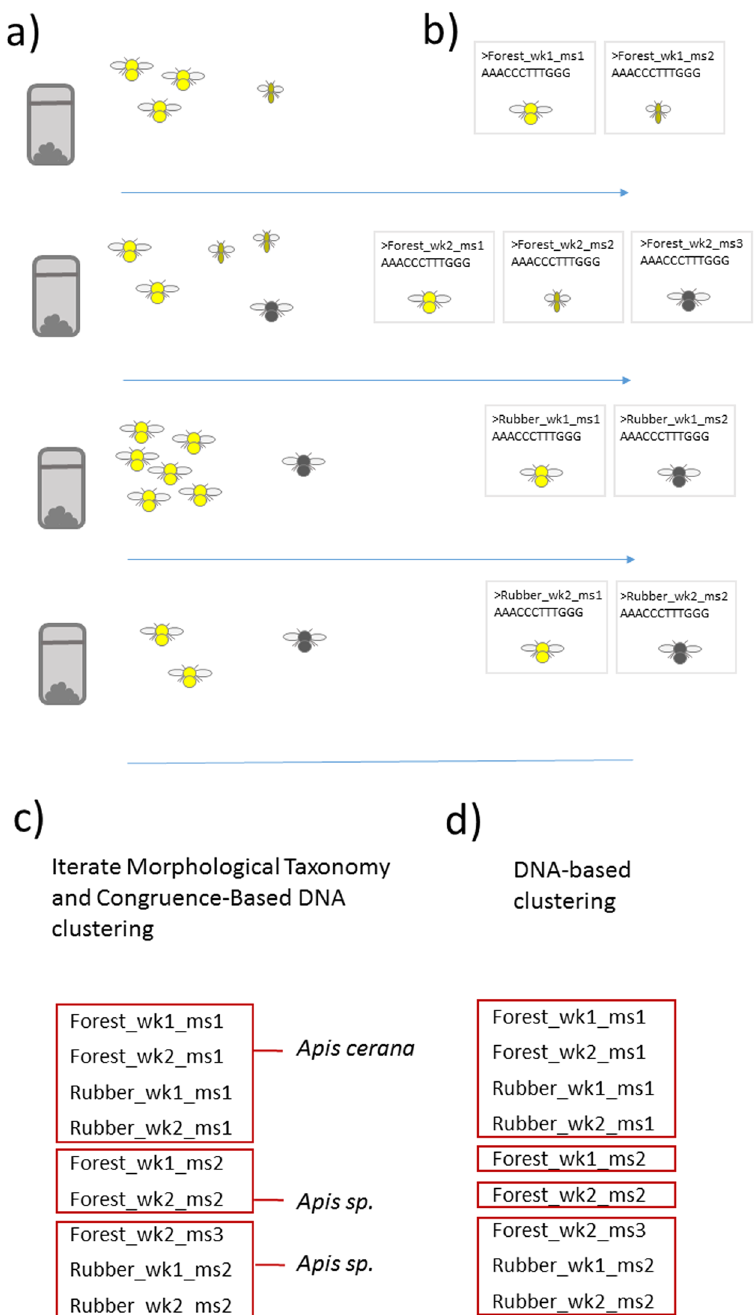
Figure 2. Overview of sorting and taxonomic protocol. ( a ) for each Malaise sample, bees were found and sorted to morphospecies, ( b ) then at least one from each sample/morphospecies is sequenced. ( c ) Morphological taxonomy and clustering of DNA (maximally congruent with species) is iterated ( d ) remaining incongruences are tested according to DNA